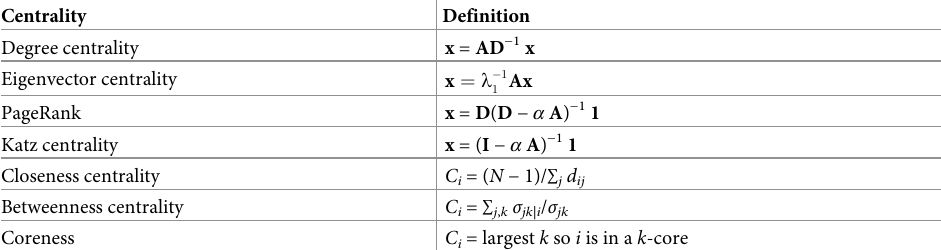
Table 1. Centrality measures. In matrix notation: x is the vector of node centralities, A is the graph adjacency matrix, λ 1 is the largest eigenvalue of A , D is the degree matrix (the diagonal matrix of node degrees), 1 is the vector of ones, and I is the identity matrix (the diagonal matrix of ones). Other notation: d ij is the number of edges on the shortest is the number of shortest paths between nodes j and k , σ is the number of shortest path between nodes i and j , σ jk jk | i path between nodes j and k which pass through i . Centrality Definition Degree centrality x = AD − 1 x Eigenvector centrality PageRank Katz centrality Closeness centrality Betweenness centrality Coreness C = largest k so i is in a k i